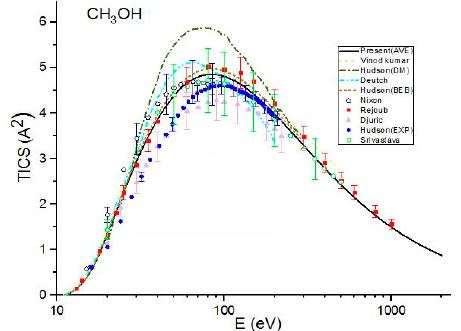
Figure 1. Total ionization cross sections (TICSs) for CH3OH in Åˆ2, the solid line represents the present (Ave.) results, the dash line represents the theoretical results measured by Vinod kumar et al. [8], the dash dot line represents the theoretical results measured by Hudson et al. [9] using Deutch–Mark (DM) formulism, the short dash dot line represents the theoretical results measured by Deutch et al. [10], the dot line represents the BEB calculations by Hudson et al. [9], the dash dot dot line represents the present (Khare BEB), and the short dash line represents the present results. Filled triangles, filled squares open circles, filled pentagons and open hexagons are the experimental results of Djuric et al. [11], Hudson et al. [9], Nixon et al. [6], Rejoub et al. [12] and Srivastava et al. [13], respectively.